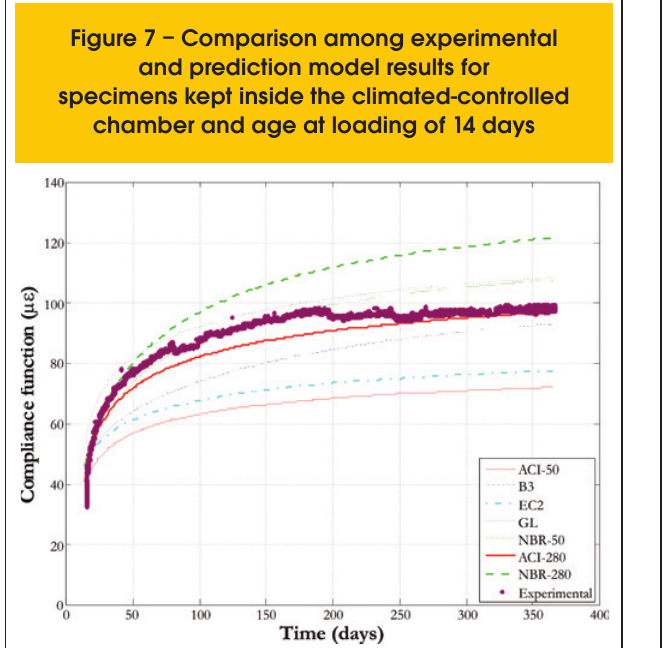
Figure 8 – Comparison among experimental and prediction model results for chamber and age at loading of 14